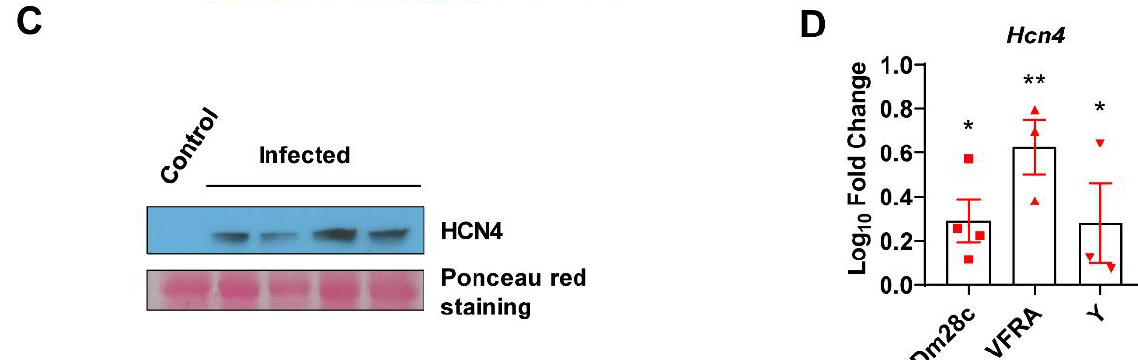
Figure 5. HCN4 expression in heart tissue. ( A ) Confocal immunofluorescence staining of auricles from control and infected mice at the EA phase using anti-Cx43 and anti-HCN4 antibodies, along with DAPI for nuclear visualization and to delimitate structural relationships in the nodal region of the right auricle. ( B ) HCN4 mean fluorescence was determined in control and infected samples. ( C ) Western blot analysis of ventricles was performed to estimate HCN4 expression in control and infected mice at the EA phase. The membrane was stained with Ponceau red before incubating with antibodies as a protein load control. ( D ) Hcn4 mRNA expression in hearts of control and infected mice at the EA phase. Fold change in each infected group was calculated compared to control (“0” value in log 10 scale). Statistical analysis was undertaken using an unpaired Student’s t-test of the infected and the control groups in B and D (* p < 0.05; ** p < 0.01).